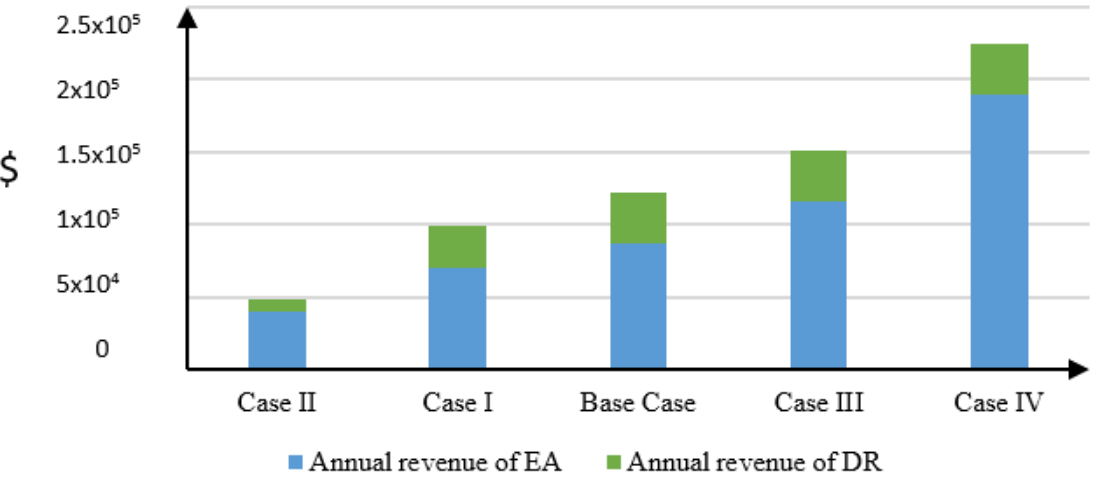
Figure 14. Results of the C-rate sensitivity case study in terms of the revenue components.